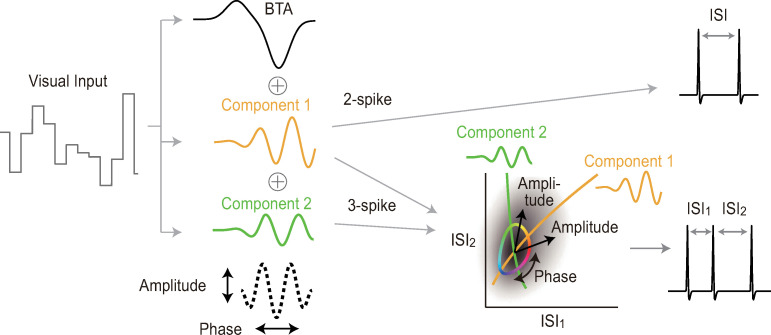
Schematic view of burst coding.The dotted line indicates the sum of the oscillatory components 1 and 2, whose amplitude and phase are encoded by the 3-spike burst pattern.